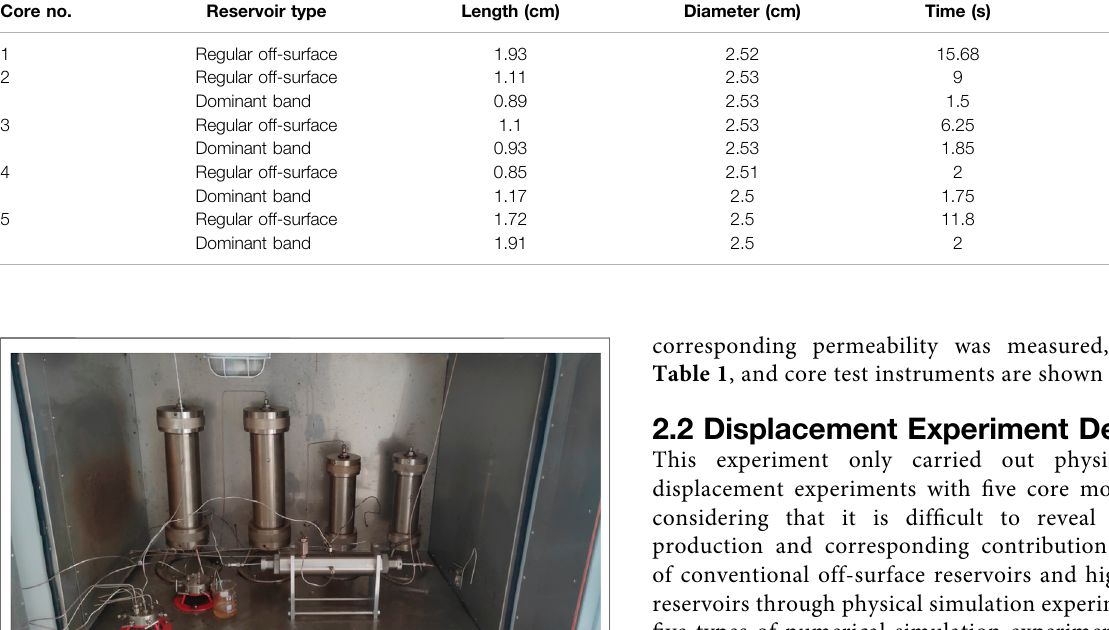
TABLE 1 | Core model construction and corresponding parameter characteristics. Core no.